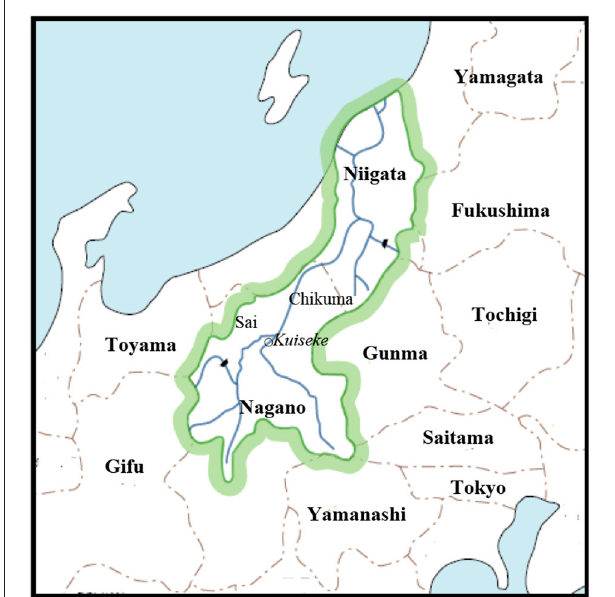
FIGURE 1 | Watershed of the Chikuma-Shinano